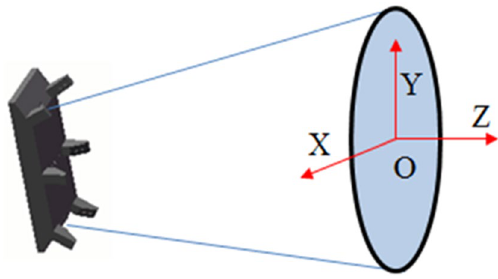
Fig. 2 Definition of coordinate